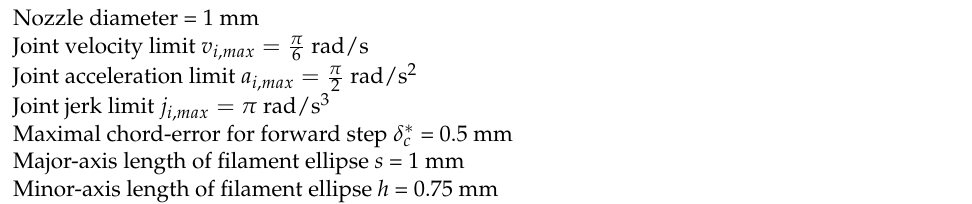
Table 1. Processing